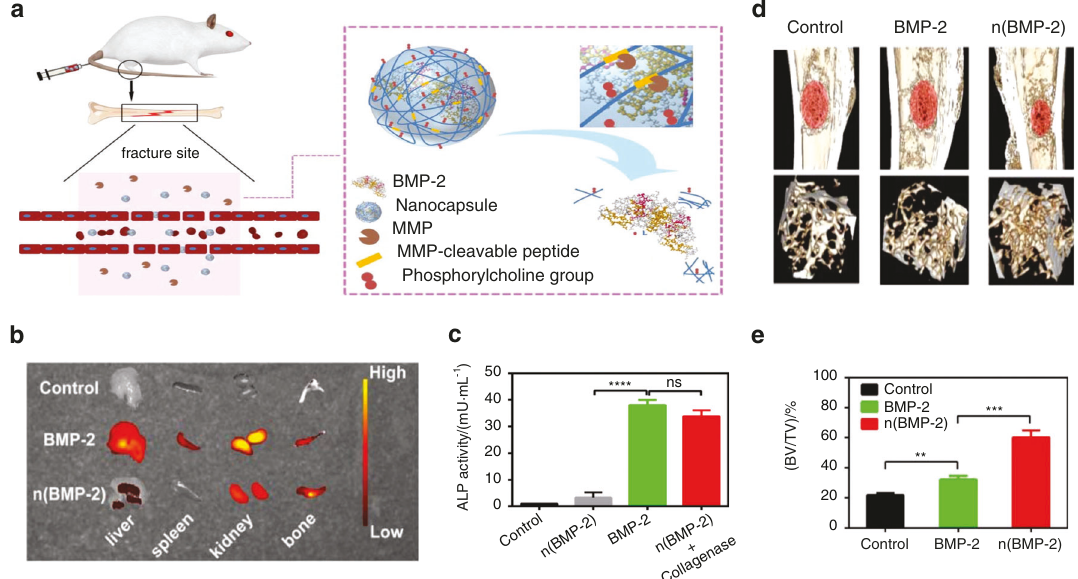
Fig. 11 Systemic administration of enzyme-responsive growth factor nanocapsules for promoting bone repair. a Illustration showing the mechanism of enzyme-responsive BMP-2 nanocapsule (n(BMP-2)) and their responsive delivery for bone fracture repair. b The distribution of BMP-2 and n(BMP-2) in bone defect site and other tissues site after intravenous injection of BMP-2 and n(BMP-2). c Comparation of the expression of alkaline phosphatase (ALP) activity of MSCs with BMP-2 or n(BMP-2) incubated (**** P < 0.000 1). d Comparation of the Micro-CT images of different therapy after rat tibial fracture. e Comparation of the volume of bone tissue per volume of total tissue (BV/TV) after different therapy (** P < 0.01, *** P < 0.001). Reproduced with permission. 127 Copyright 2019, Royal Society of